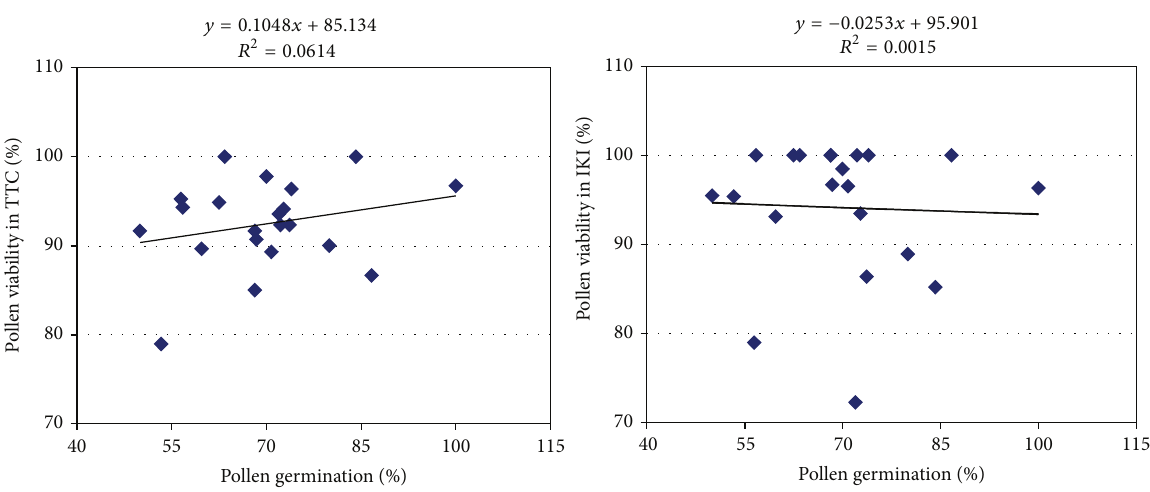
Figure 4: Correlation between the pollen staining test and pollen germination